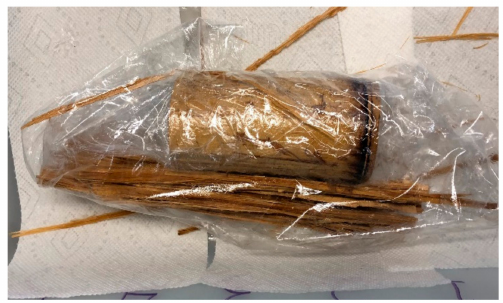
Figure 10. S-3 sprayed bamboo samples covered in a plastic wrap so that the S-3 stays in contact with the impregnated